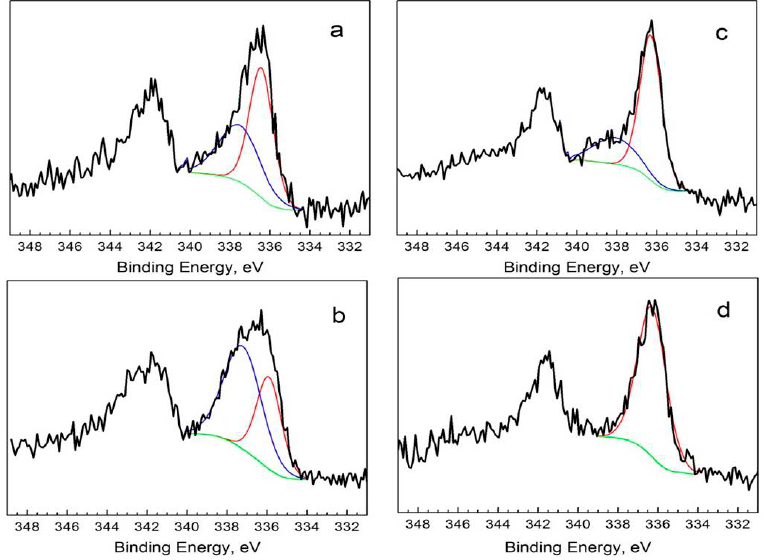
phases. The same picture is observed with Pd-LMO/U-AACVD sample (not shown here). LMO/Imp and Pd-LMO/U-AACVD.